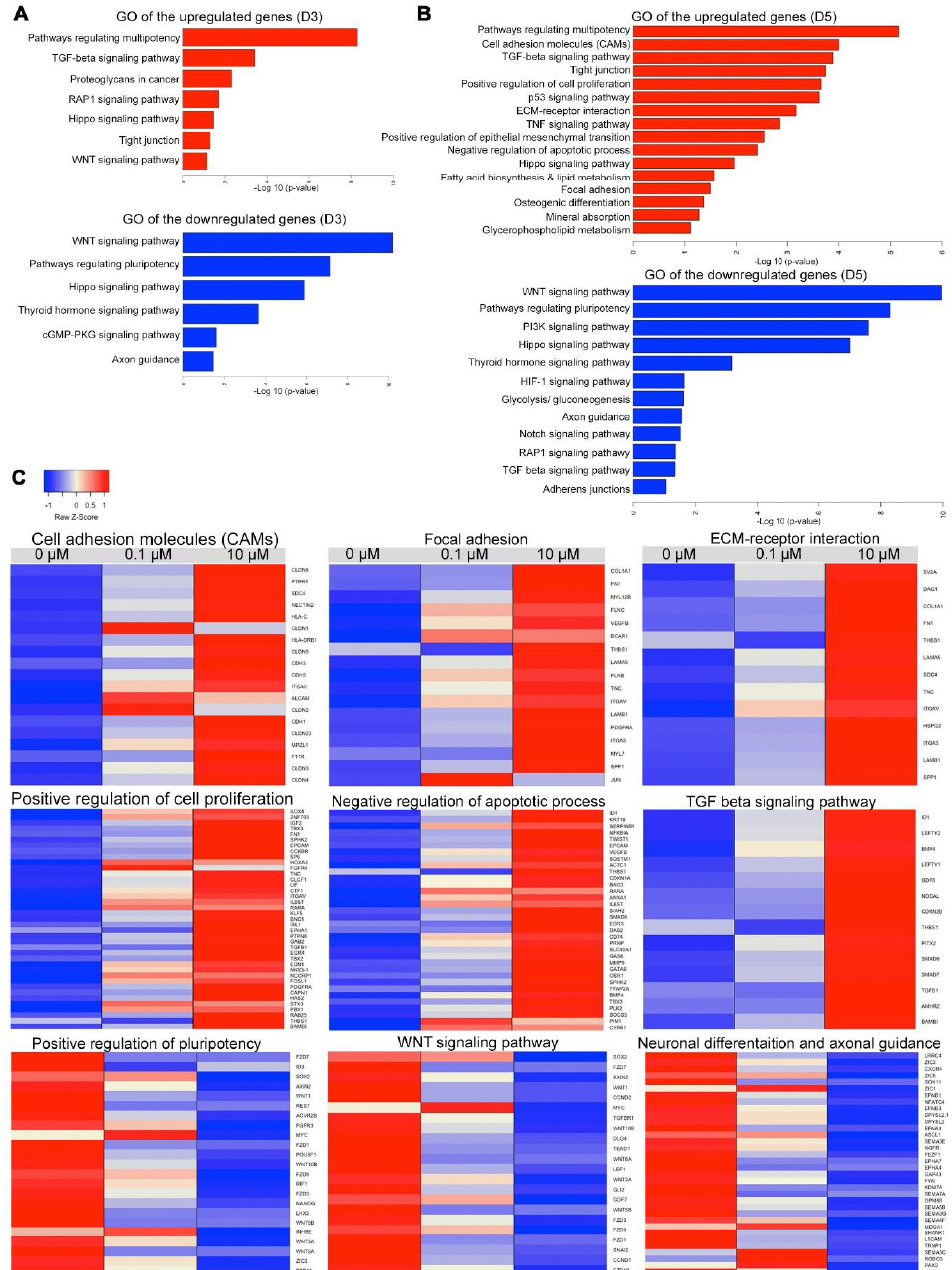
Figure 6. Differentially expressed genes in differentiated cells following RA treatment. Gene Ontology (GO) and Kyoto Encyclopedia of Genes and Genomes (KEGG) enrichment analysis of biological processes for upregulated and downregulated differentially expressed genes (DEGs) in H9-hESC-derived EBs treated with 10 μM RA or untreated EBs examined at day 3 ( A ) and day 5 ( B ). The enriched GO terms and KEGG pathways were plotted against –log10 ( p -value). ( C ) Heatmaps showing DEGs in H9-hESC-derived EBs treated with 10 µM RA compared to those treated with 0.1 µM RA and untreated EBs at day 5 of differentiation. The upregulated genes were associated with cell adhesion molecules (CAMs), focal adhesion, ECM-receptor interaction, positive regulation of cell proliferation, negative upregulation of apoptotic process and TGF beta signaling pathway, while the downregulated genes were associated with positive regulation of pluripotency, WNT signaling pathway, neuronal di ff erentiation and axonal guidance. The relative value for each gene is depicted by color intensity, with red indicating upregulated and blue indicating downregulated genes. See also Figure S4, Tables S1 and